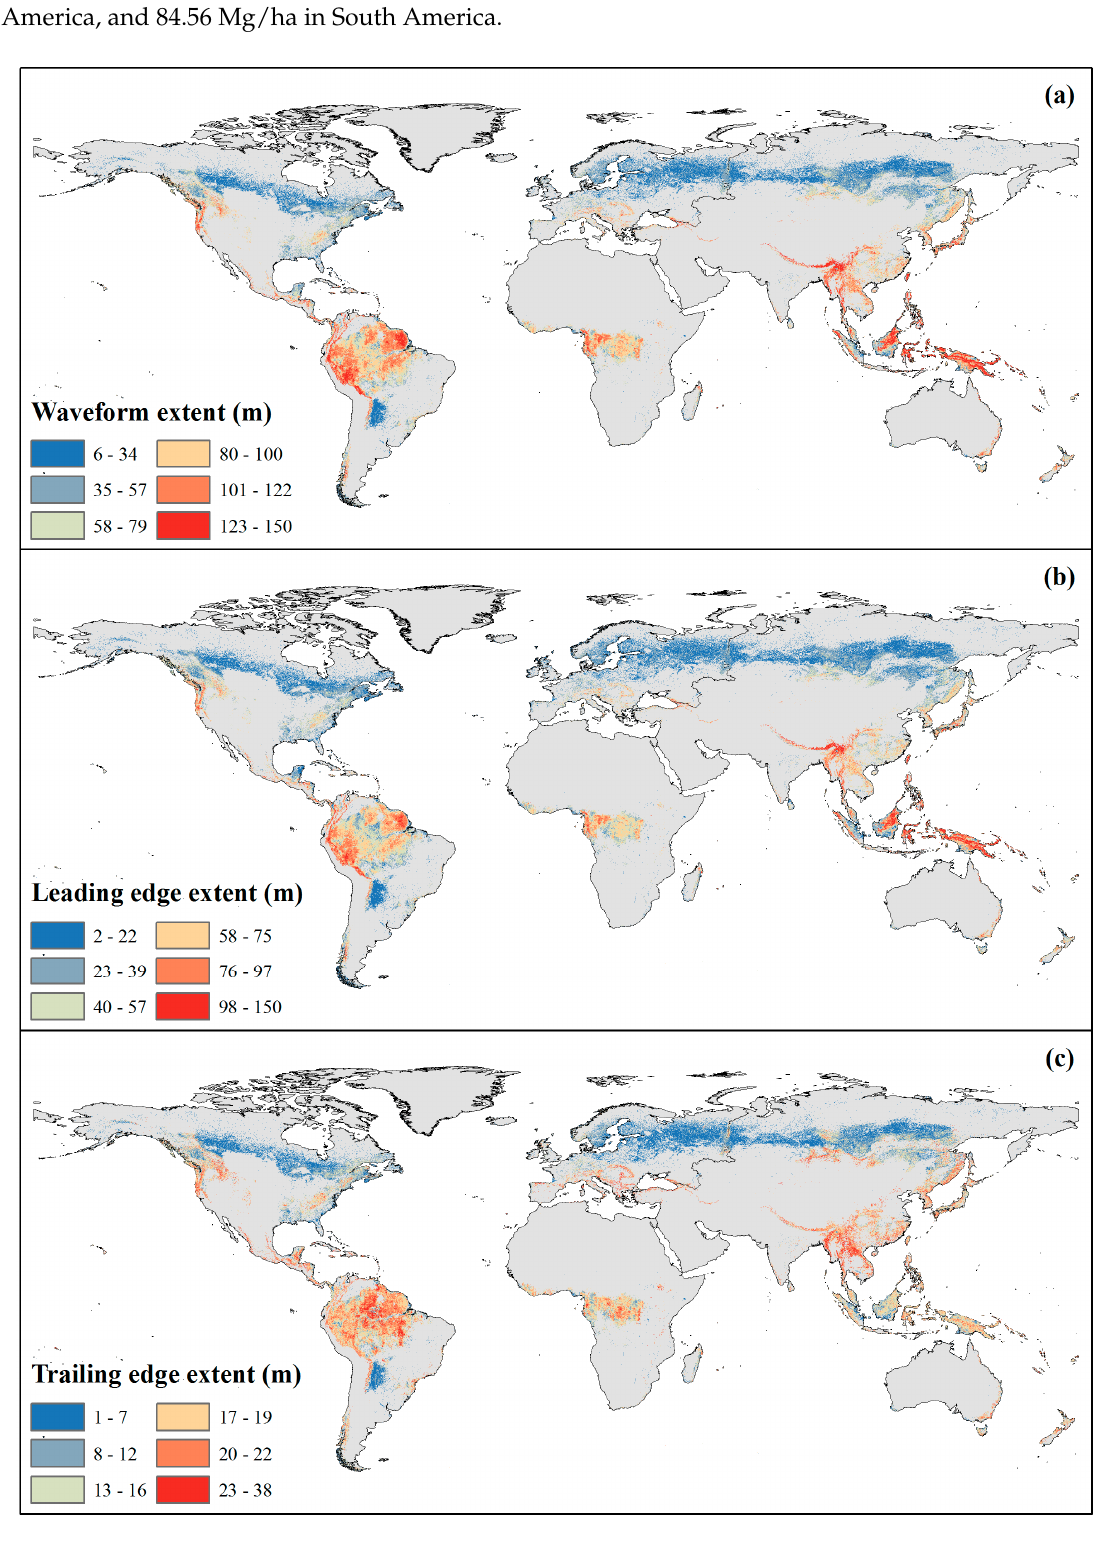
Figure 3. Distributions of extrapolated GLAS-derived full-waveform parameters, ( a ) waveform extent; ( b ) leading edge extent; and ( c ) trailing edge extent. Note that non-forest coverage has been excluded from the maps.